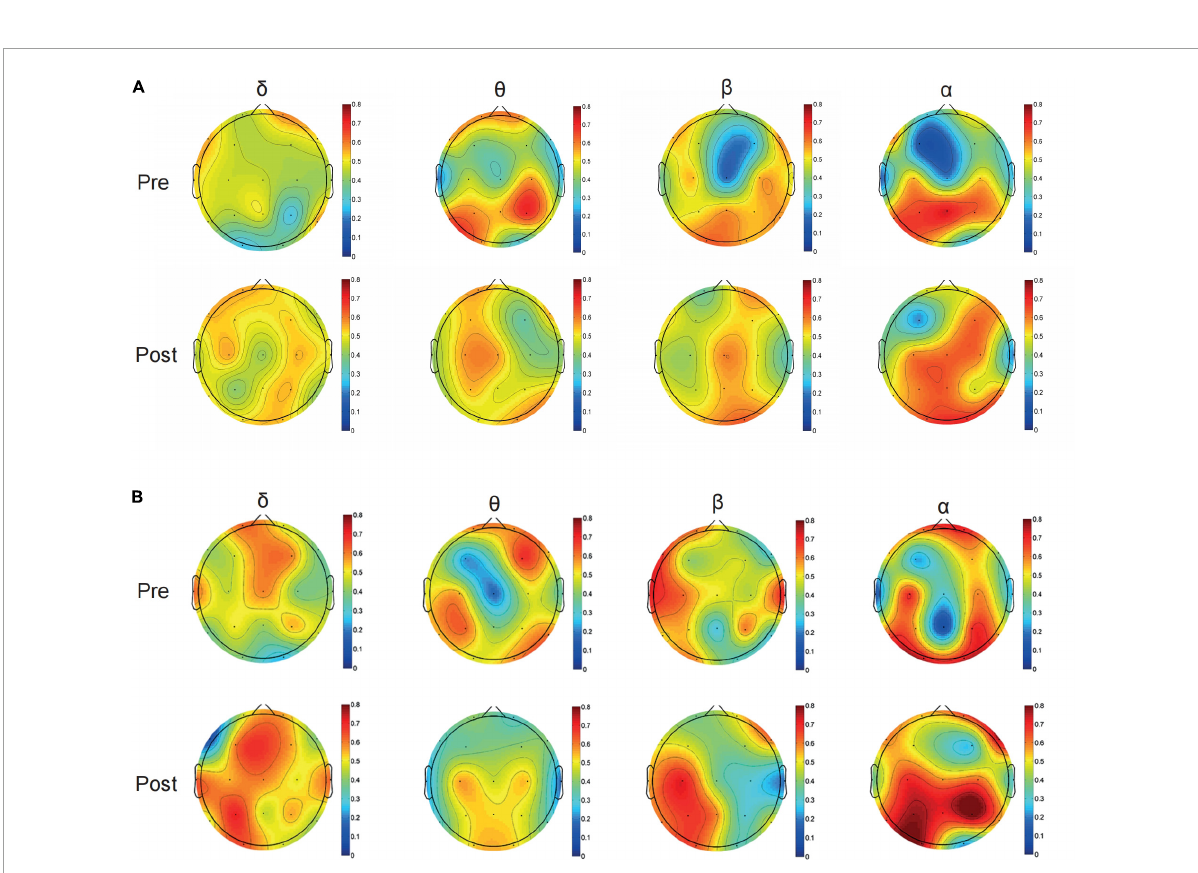
FIGURE5 Typical topographical maps of power density [using the average local efficiency (LE)] Delta band, Theta band, Beta band, and Alpha band of control group (A) and Qigong group (B) after treatment, the frequency spectrum of (Fp1.Fp2.F3.F4), (T3.T4.T5), (P3) are mainly different in δ band; the frequency spectrum of the whole brain is different in θ band; and (T3.T5), (C3), (P3.Pz), (O1), and a small part (F8) are different in β band; the frequency spectrum of (FP1.FP2), (P3), and (O1.O2) are different in α